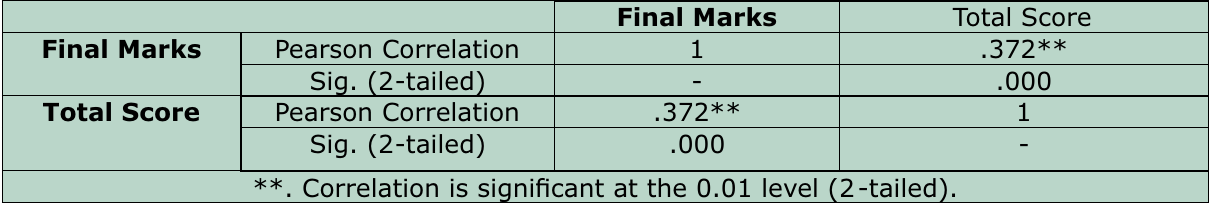
Table-III: Correlations between Metacognition score and academic achievement.